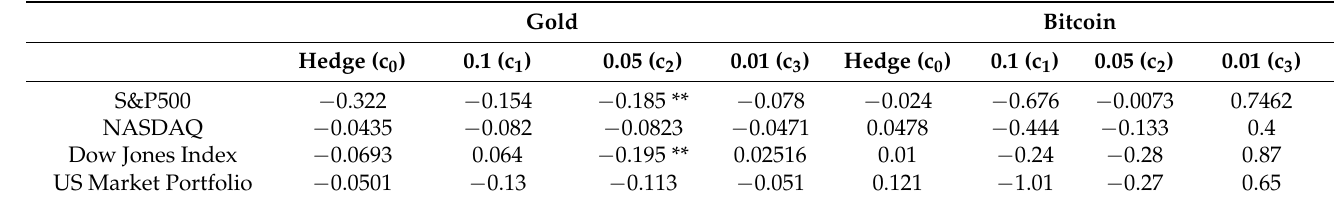
Table 3. Estimated Parameters for Safe Haven and Hedge Testing for gold and Bitcoin from October 2017 to February 2020. ** represents 95% confidence level.